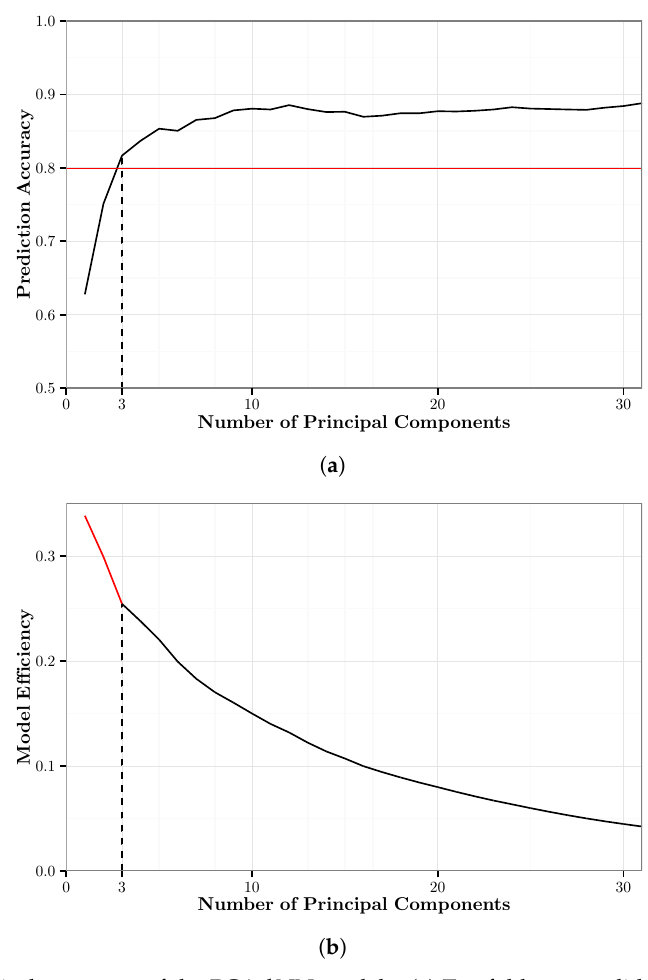
Figure 3. A graphical summary of the PCA- k NN models. ( a ) Ten-fold cross-validation accuracy of the PCA- k NN models. The solid black line represents the prediction accuracy; the solid red line represents the minimum cut-off accuracy for the optimal model; and the dashed black line represents the minimum number of principal components necessary to attain the cut-off accuracy. ( b ) Model efficiency metric of the PCA- k NN models. The red portion represents models that do not meet the cut-off accuracy; the black portion represents models that do meet the cut-off